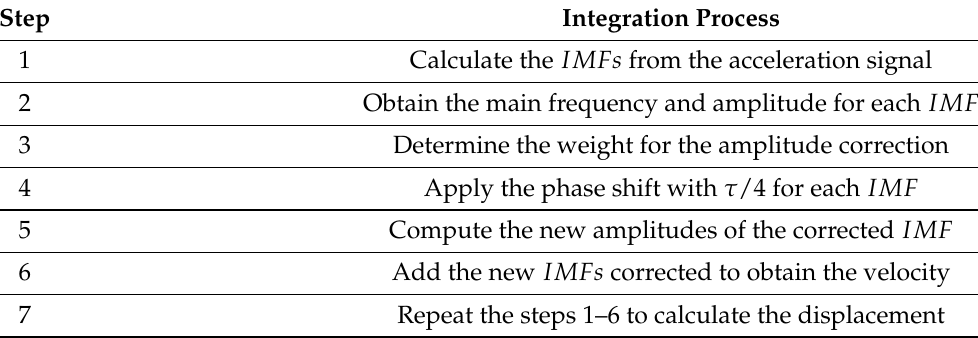
Table 1. Steps for the proposed integration